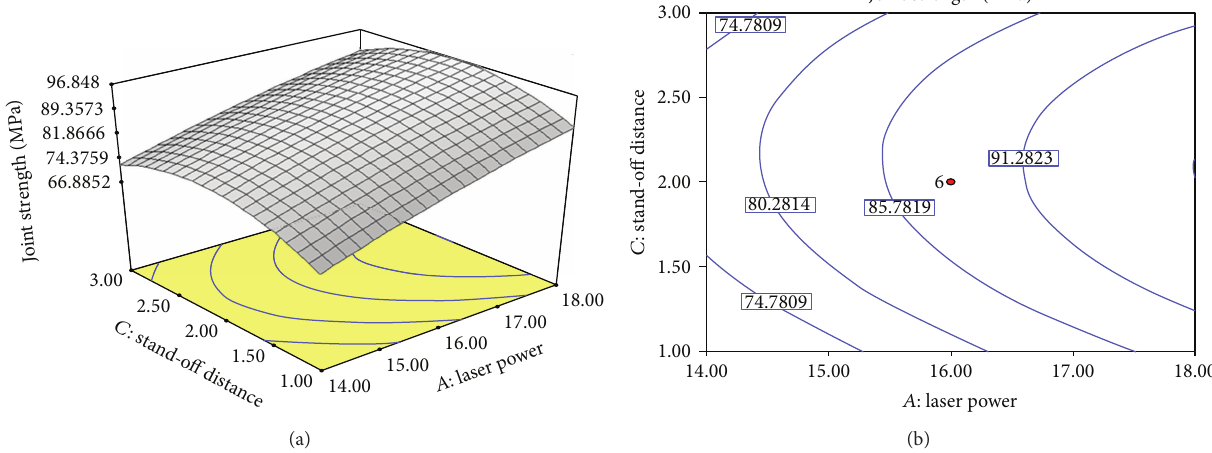
Figure 9: Interaction effect of laser power and stand-off distance on the joint strength. (a) 3D interaction; (b) the contour plot.